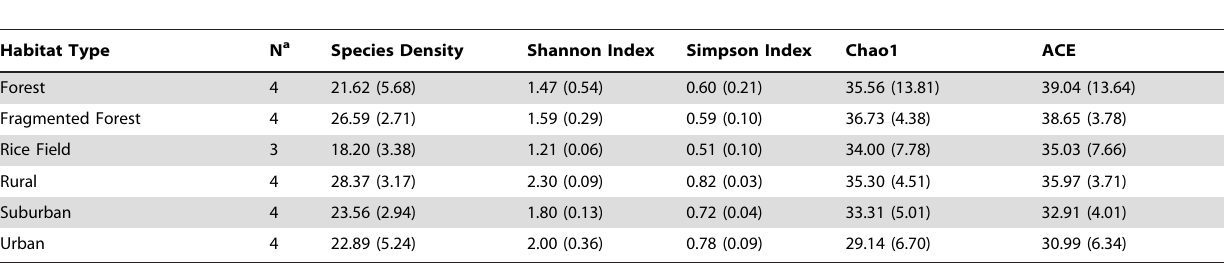
Table 2. Mean species richness and diversity indices ( 6 95% Confidence Interval) of mosquito communities found in six habitat types of Nakhon Nayok Province, Central Thailand, in